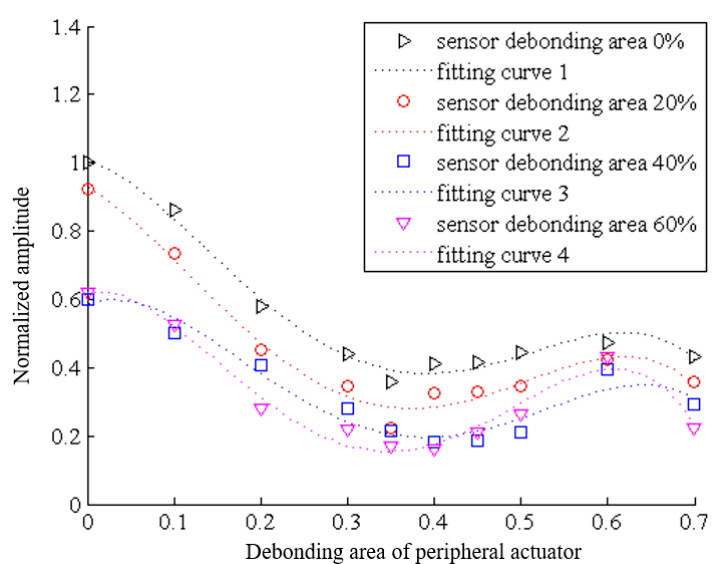
Figure 13. When the debonding area of the central sensor is 0%, 20%, 40% and 60%, the changes of normalized amplitude of the signal with the increase of the debonding area of the peripheral actuator, the excitation frequency is 50 kHz.